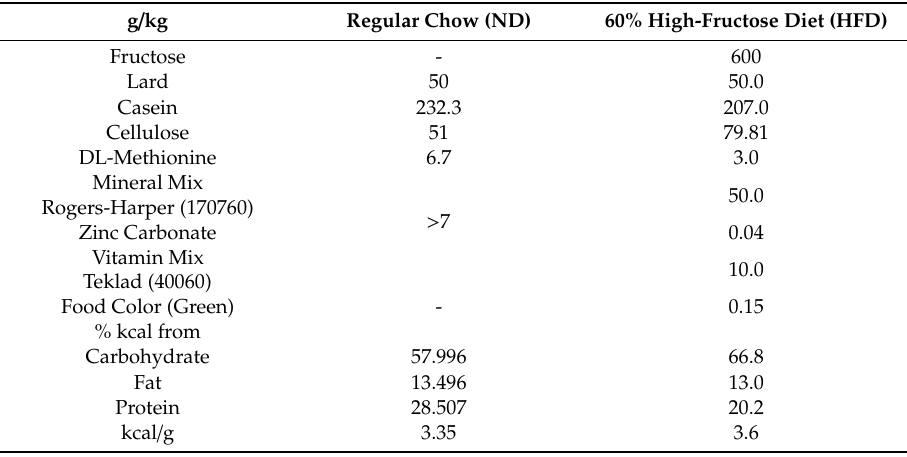
Table 1. The dietary contents of regular chow (ND) and high-fructose diet